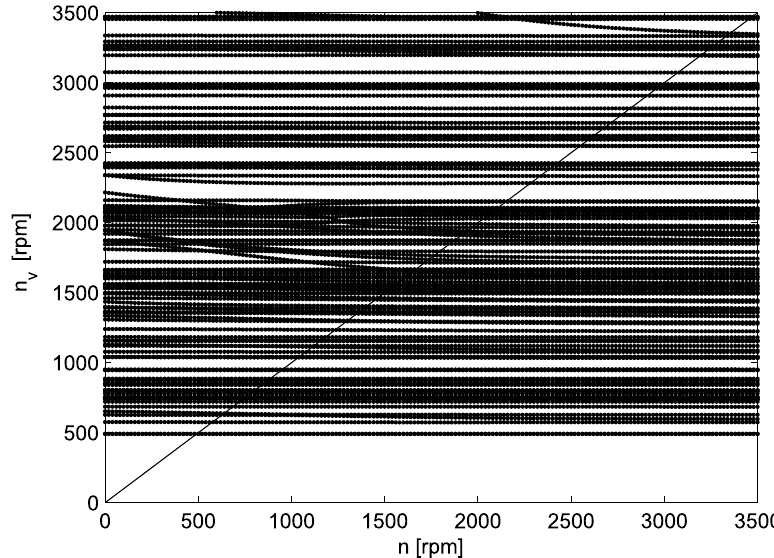
Figure 14. The useless Campbell diagram calculated using model C (the complex rotor and founda- tion